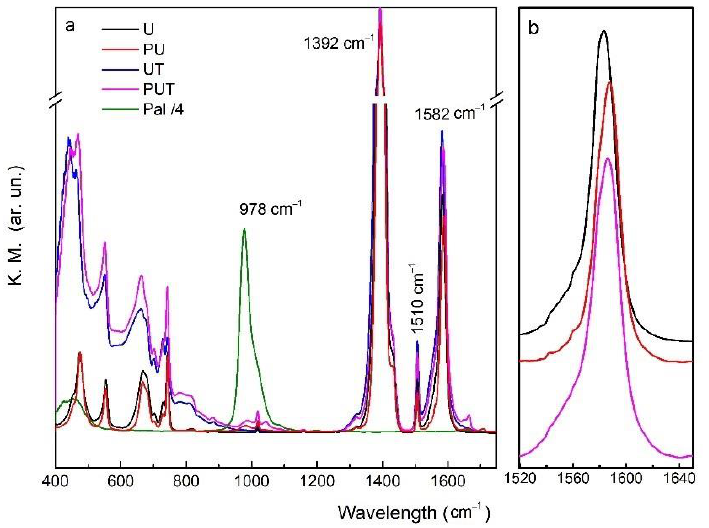
Figure 2. ATR spectra of all prepared materials ( a ); zoomed area of the COO − group vibration mode ( b ).